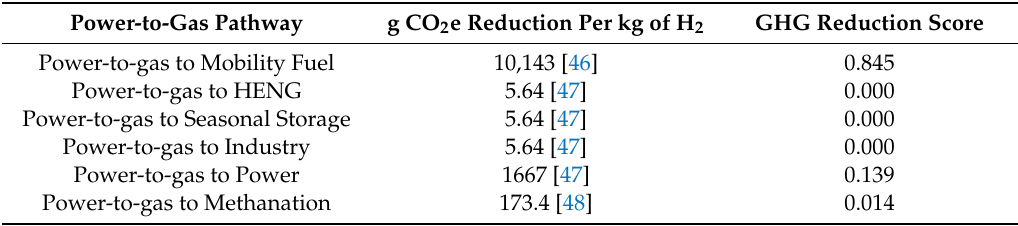
Table 7. Greenhouse gas (GHG) Reductions for power-to-gas Pathways—GHG Reduction